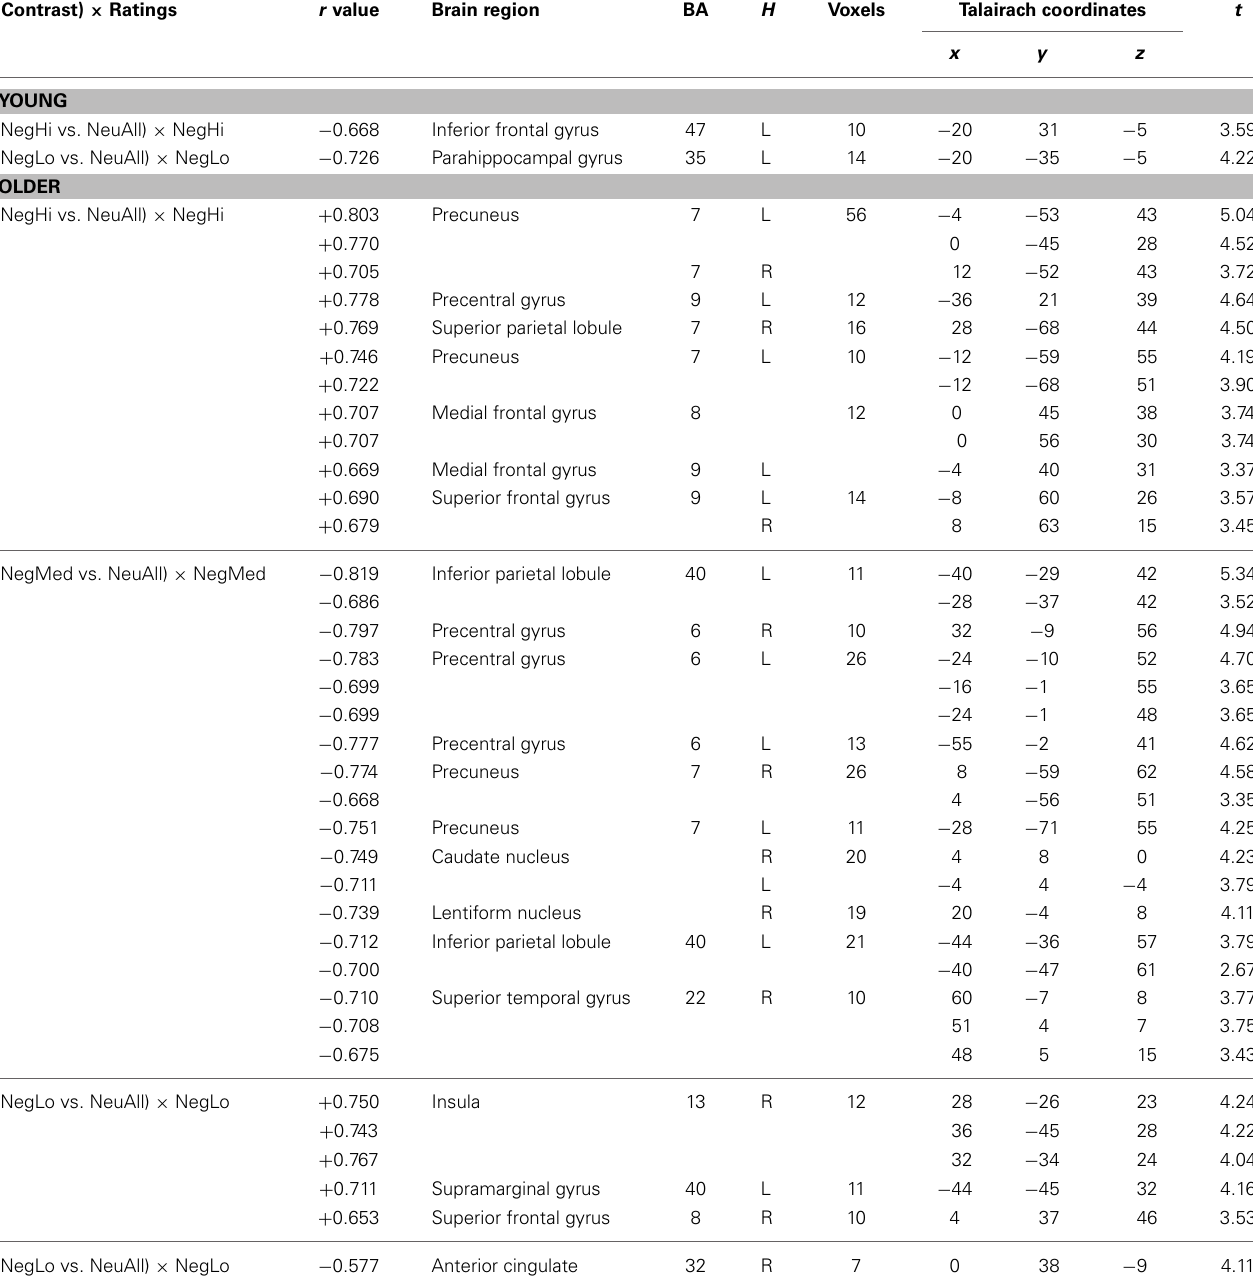
Table 6 | Co-variations between brain activity and the ratings of negative pictures by young and older adults. (Contrast) × Ratings r value Brain region BA H Voxels Talairach